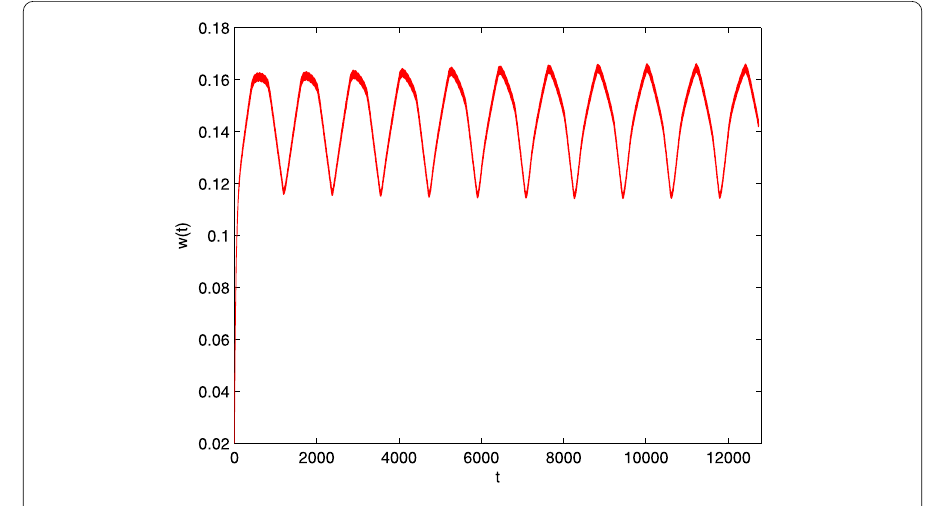
Figure 1 Numerical results of model (4.1): t – w ( t